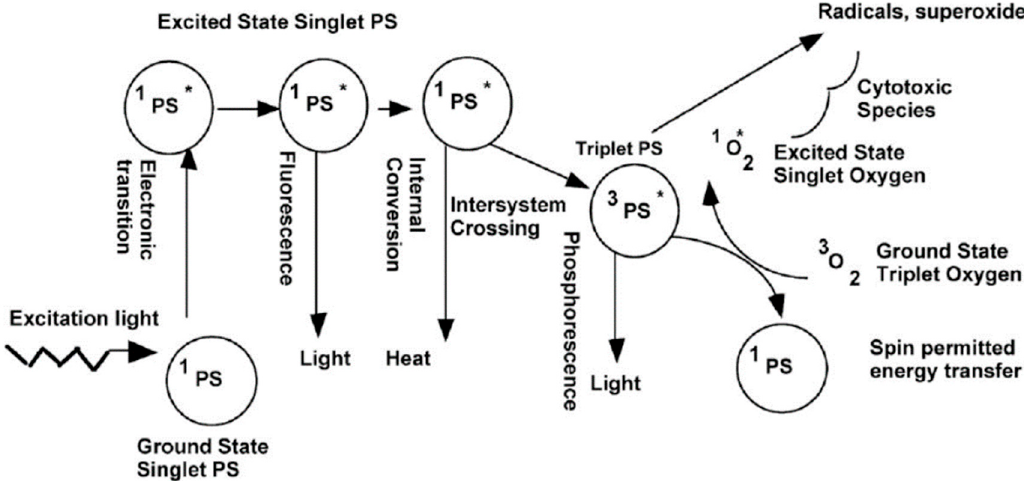
Figure 11. Photodynamic therapy mechanism. The photosensitizer (PS) is excited by external radiation, the excited electron may decay through di ff erent phenomena which may end in the generation of cytotoxic species, like ROS. Adapted from ref.